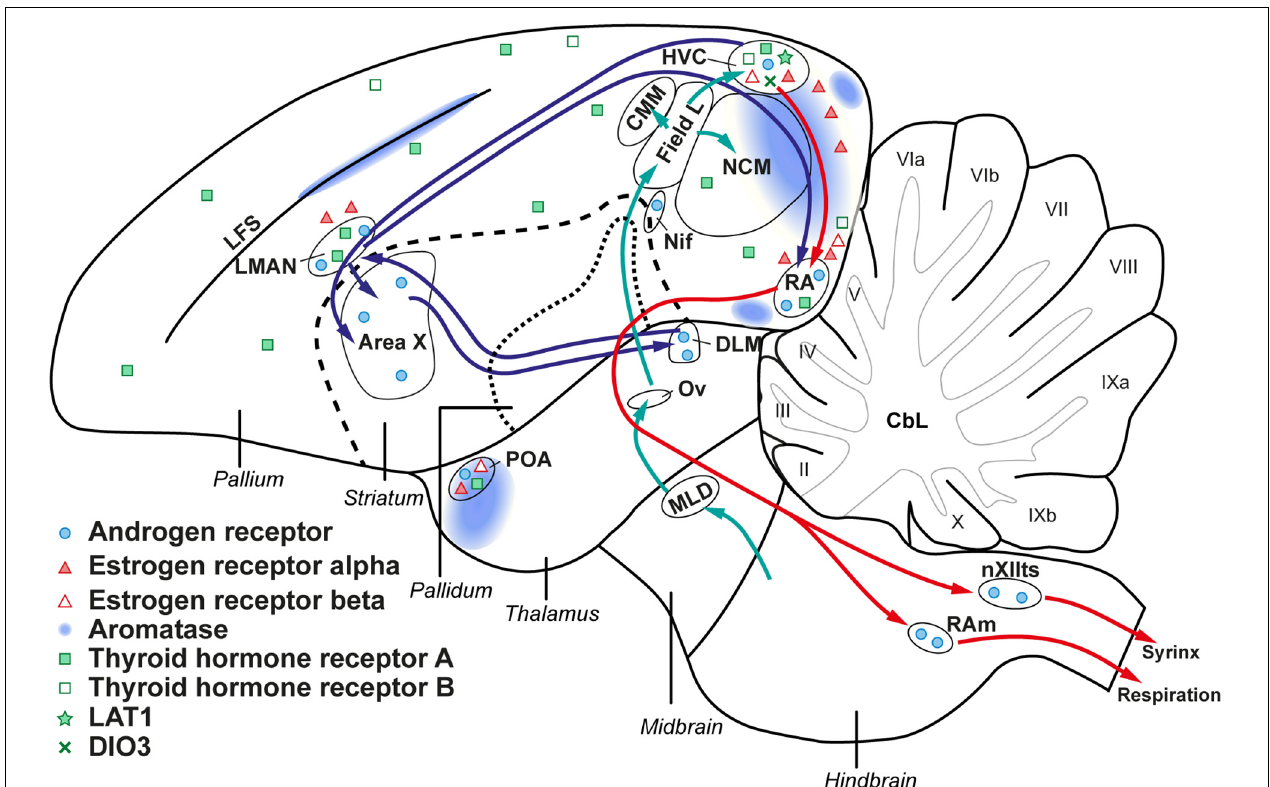
FIGURE 10 | Schematic overview of the steroid and thyroid hormone receptors within the songbird brain. Androgen receptor, estrogen receptor, and aromatase expression is based on prior studies in starlings and canaries (Gahr, 1990; Bernard et al., 1999; Metzdorf et al., 1999). The expression of thyroid hormone regulating genes is derived from our own